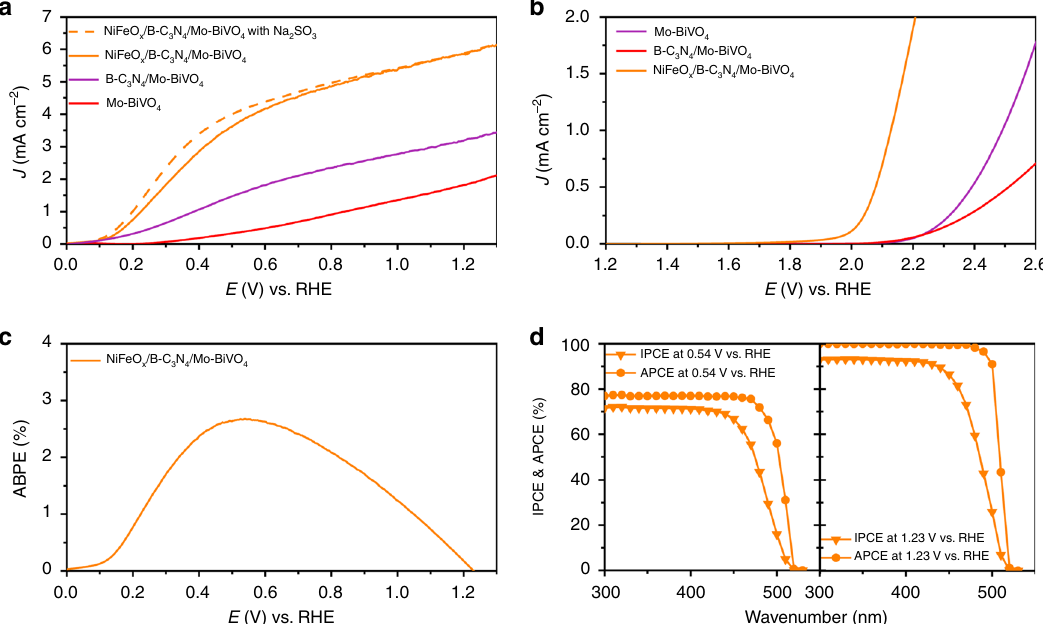
Fig. 4 Photoelectrochemical performances. LSV curves of the Mo-BiVO 4 , B-C 3 N 4 /Mo-BiVO 4 and NiFeO x /B-C 3 N 4 /Mo-BiVO 4 recorded at a scan rate of 25 mV s − 1 in PPB solution without Na 2 SO 3 as a hole scavenger (pH 7) a under AM 1.5 G irradiation and b in dark. c ABPE of NiFeO x /B-C 3 N 4 /Mo-BiVO 4 . d IPCE and APCE of NiFeO x /B-C 3 N 4 /Mo-BiVO 4 at 0.54V vs. RHE (left) and 1.23 V vs. RHE (right) in PPB solution (pH